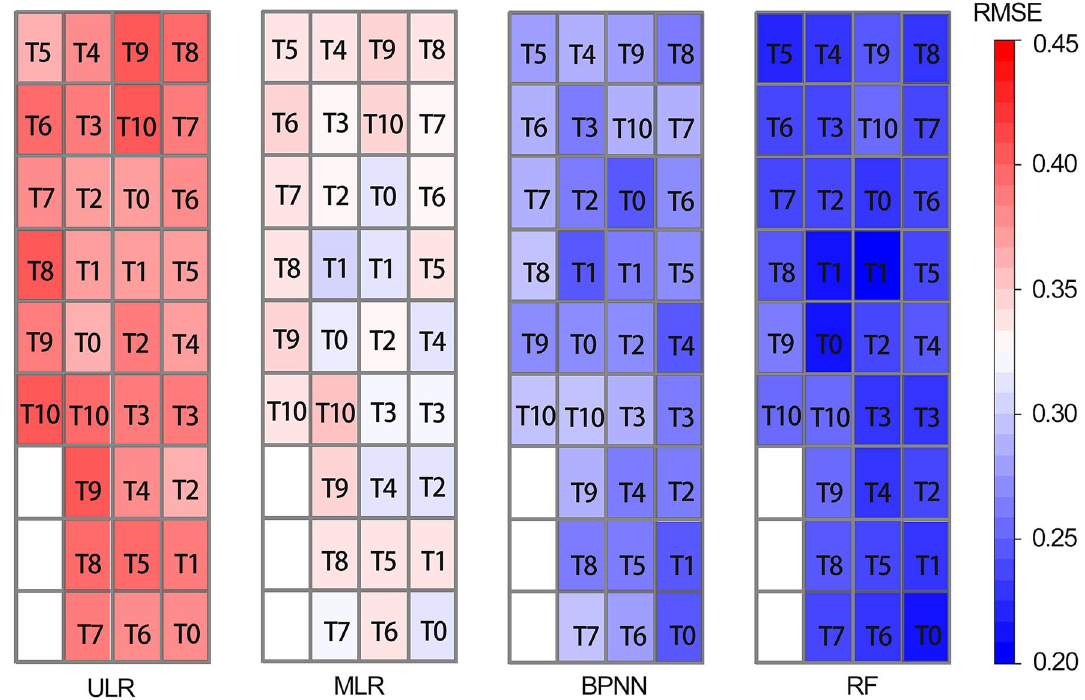
Figure 10. RMSE between the predicted LAI and the measured values for the whole experimental